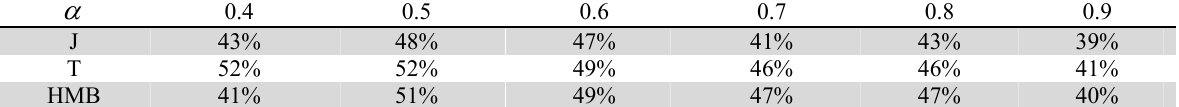
Comparison of the IM for variable variance base on  in constant variance mode (The number of machines = 2, The number of Jobs = 10, Means 130-170, Variance = 900)